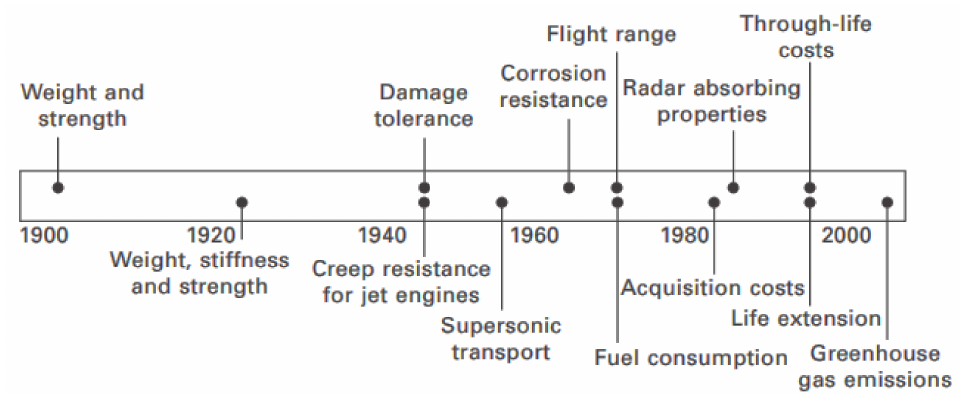
Figure 1. Historical timeline indicating when critical measures for materials selection were introduced into aircraft design